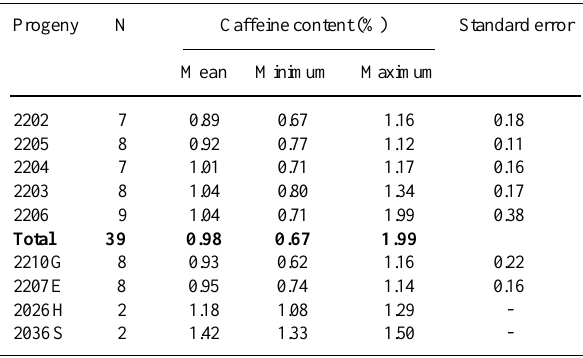
Table III - Caffeine content (%) of beans from five Coffea arabica progenies from the Gojjam region and one progeny from each of the other four Ethiopian